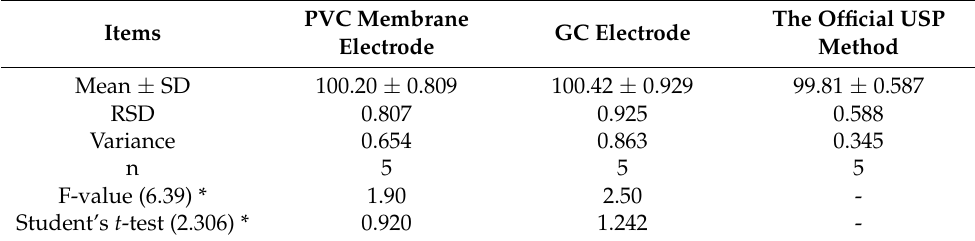
Table 8. Statistical treatment of the results obtained by the suggested ion-selective electrodes in comparison with the official